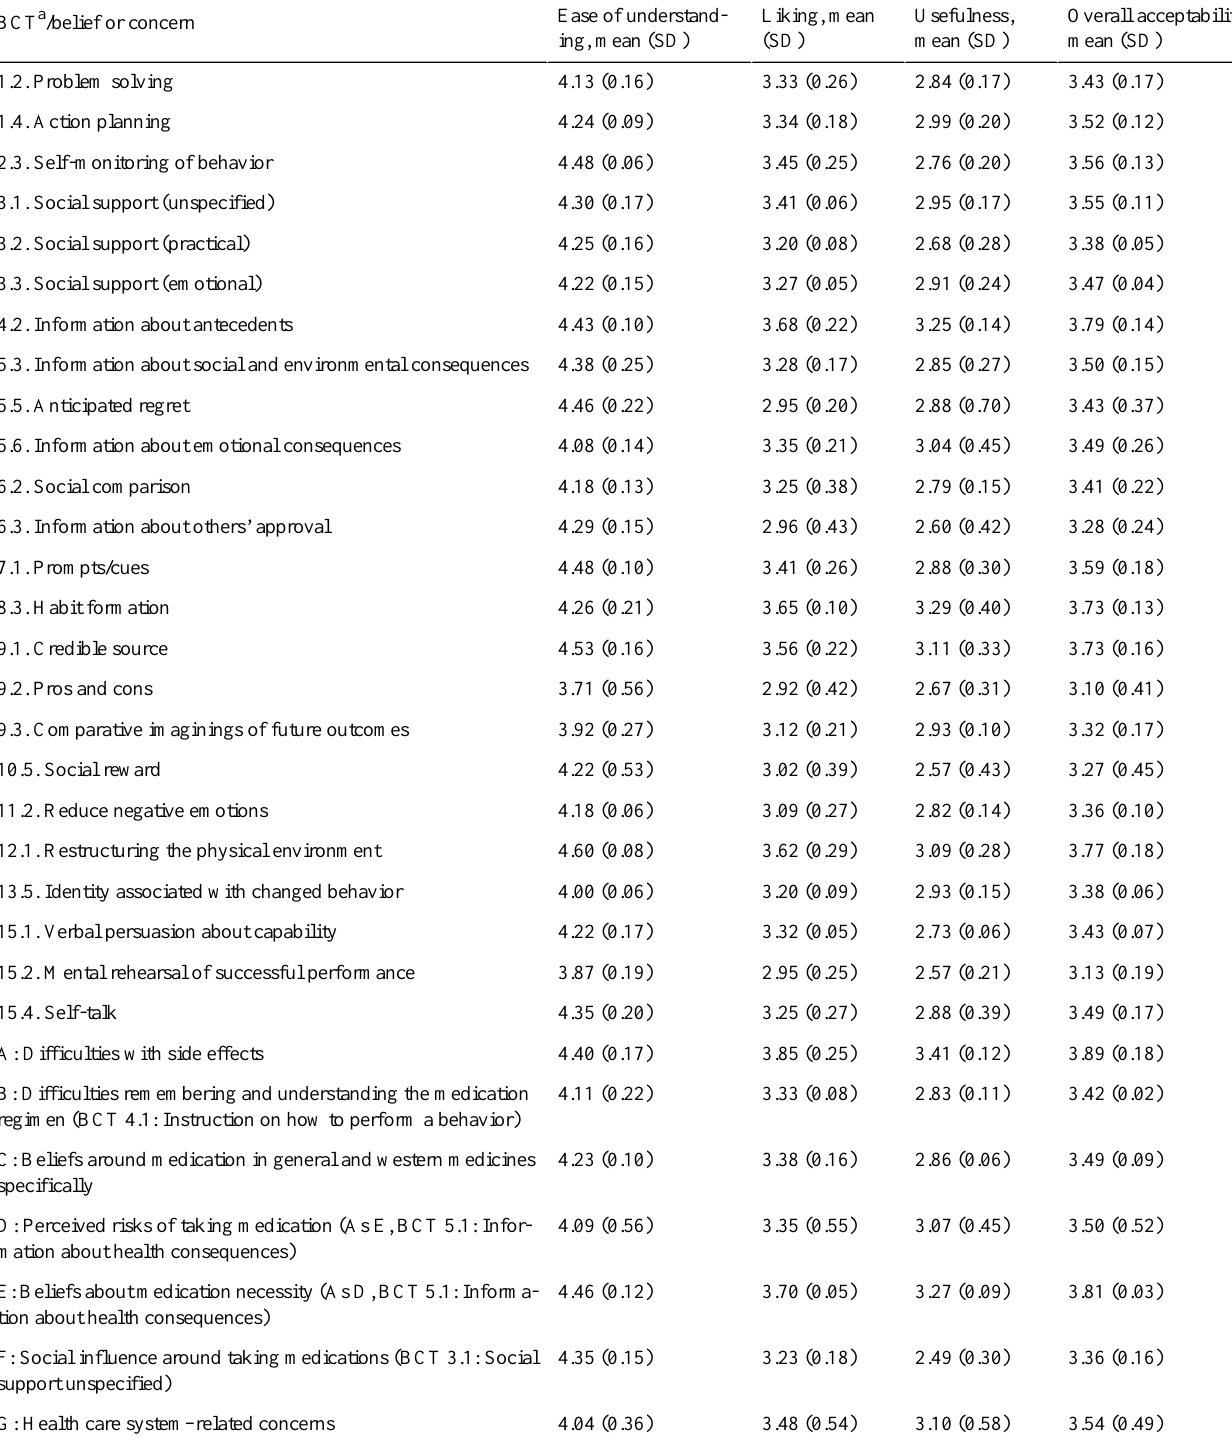
Table 4. Ease of understanding, liking, usefulness, and acceptability scores per behavior change technique or belief or concern from study 3. All available message reviews from participants (n=61) were